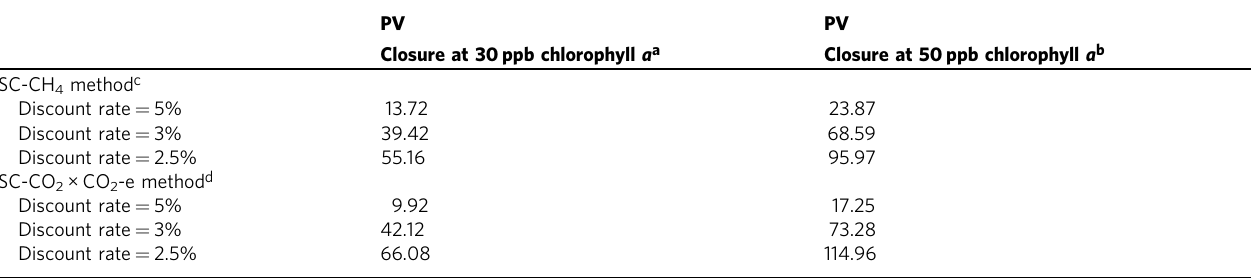
Table 3 Present value (PV) of global social costs of CH 4 emissions, 2015 – 2050 (billion 2015 US$), from a harmful algal bloom suf fi cient to close all MI and OH beaches on Lake